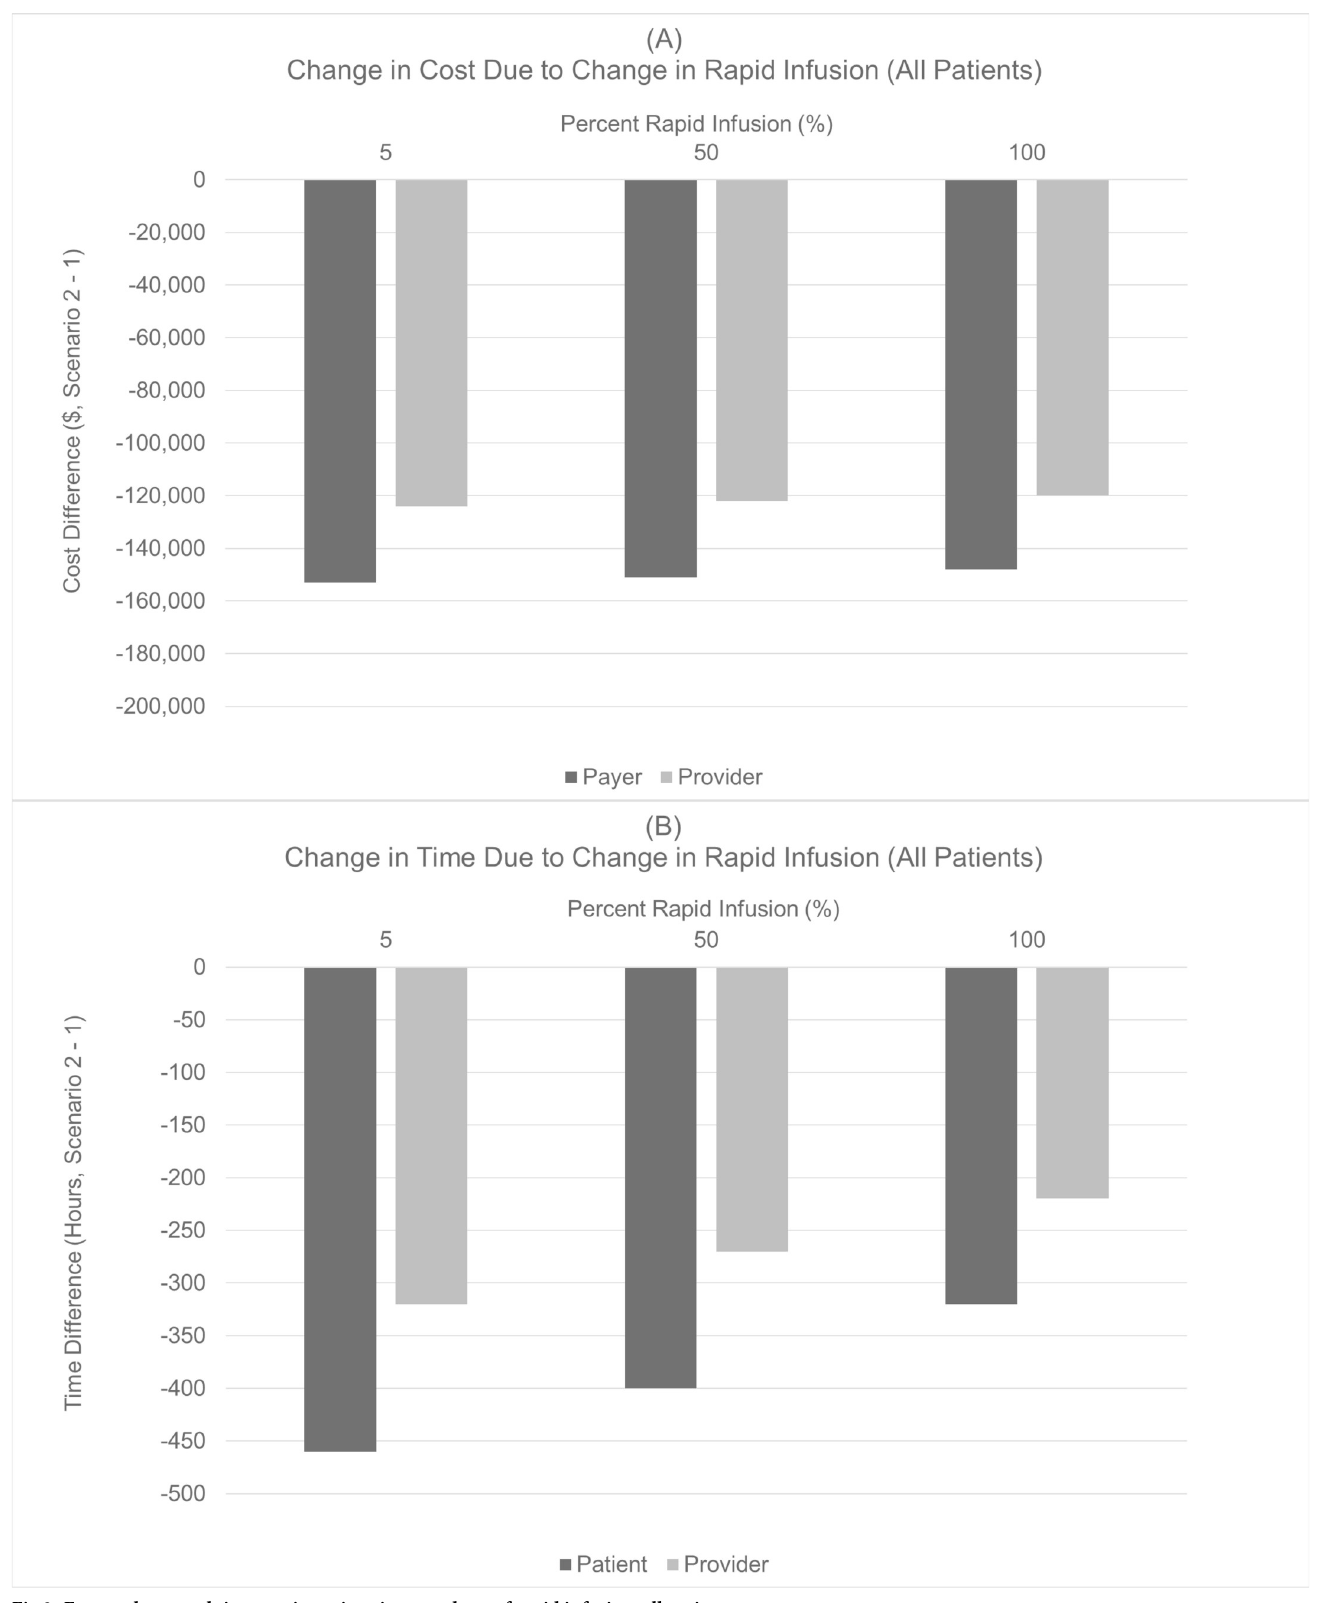
Fig 3. Expected cost and times savings given increased use of rapid infusion, all patients. https://doi.org/10.1371/journal.pone.0261336.g003 PLOS ONE | https://doi.org/10.1371/journal.pone.0261336 January 24,